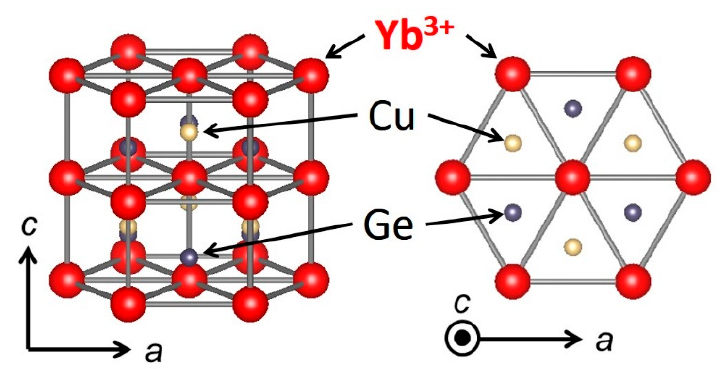
Figure 1. Crystal structure of YbCuGe with a triangular lattice of Yb atoms in the c plane of the hexagonal NdPtSb-type structure.